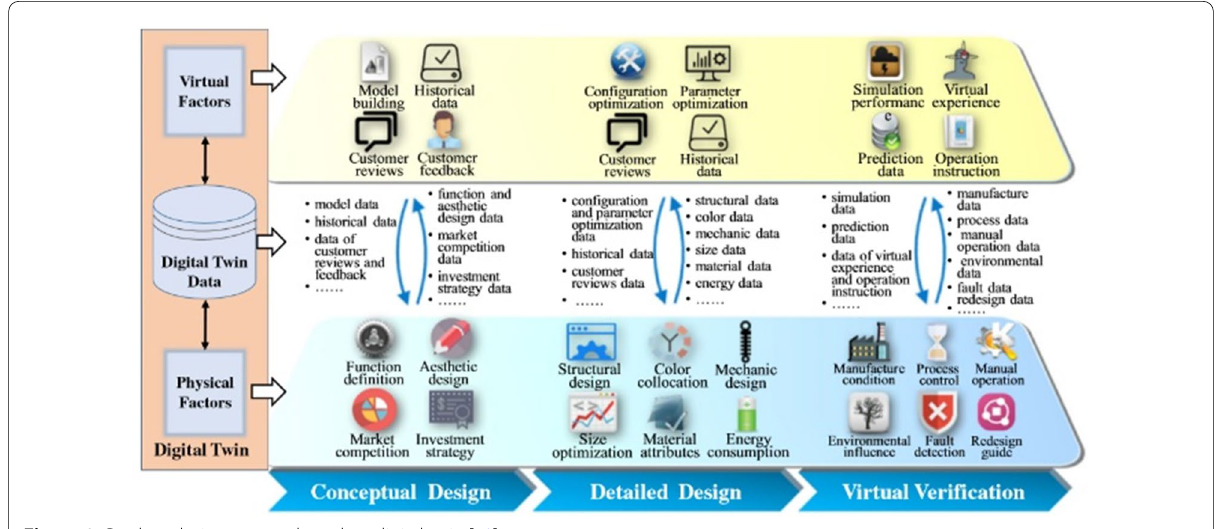
Figure 2 Product design process based on digital twin